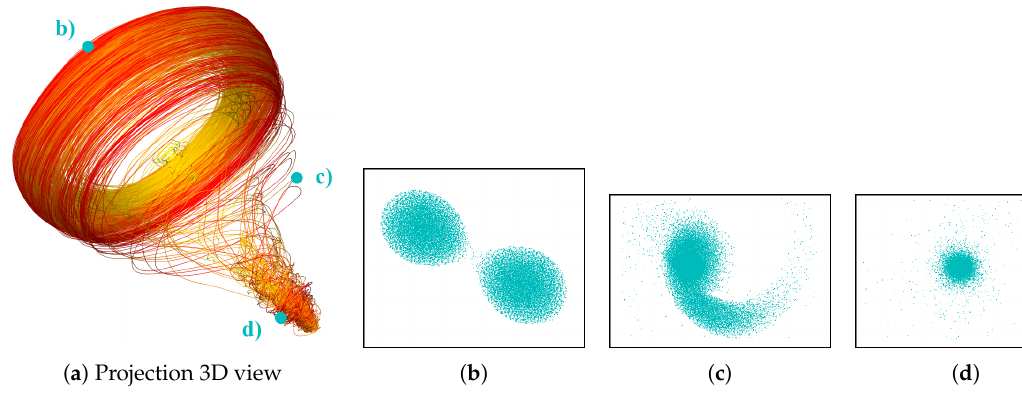
Figure 12. 3D similarity plot ( a ) with selected keyframes displayed in linked views to the domain visualization ( b – d